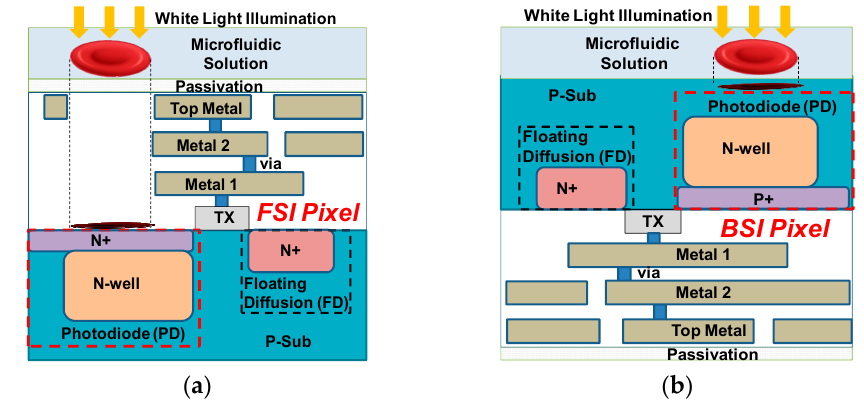
Figure 2. Comparison of front-side illuminated (FSI) and back-side illuminated (BSI) complementary metal oxide semiconductor (CMOS) image sensor pixel. ( a ) FSI pixel whose photodiode (PD) is far from the cell sample; and ( b ) BSI pixel whose PD is in close proximity with the cell sample.